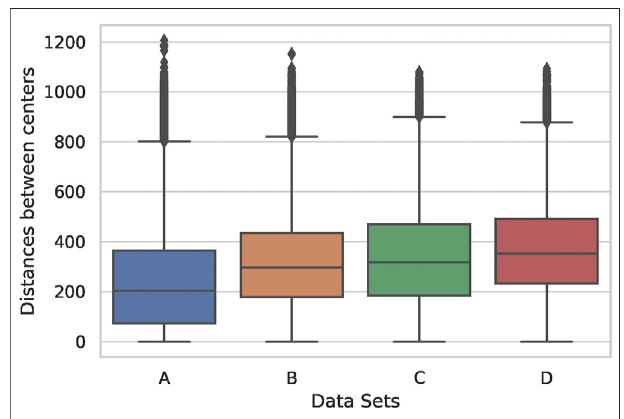
FIGURE7| Boxplotsofdistancesbetweenattendedobjectsdepending on thematic relatedness and depth of the layer. The vertical axis has measurements in pixels. Names of the data sets correspondto the conditions described in Figure 6